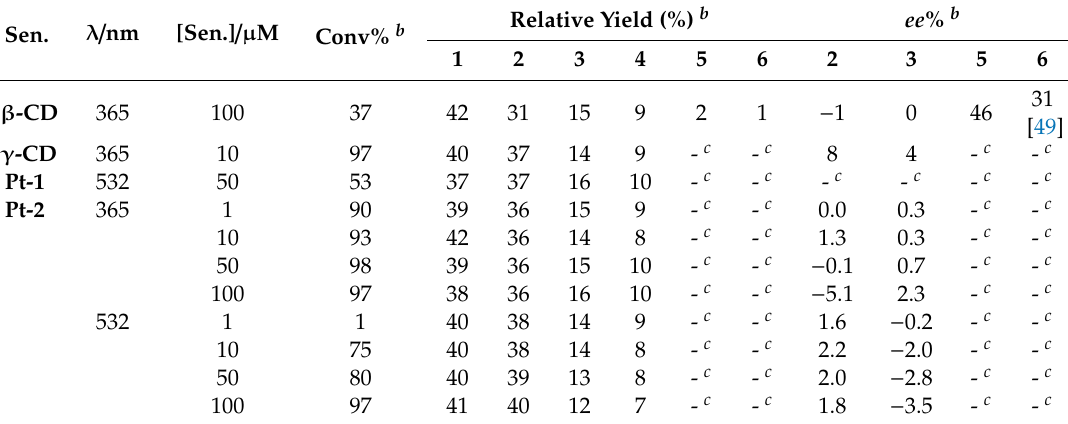
Table 1. Photocyclodimerization of AC (0.2 mM) mediated by Pt-1 and Pt-2 a .